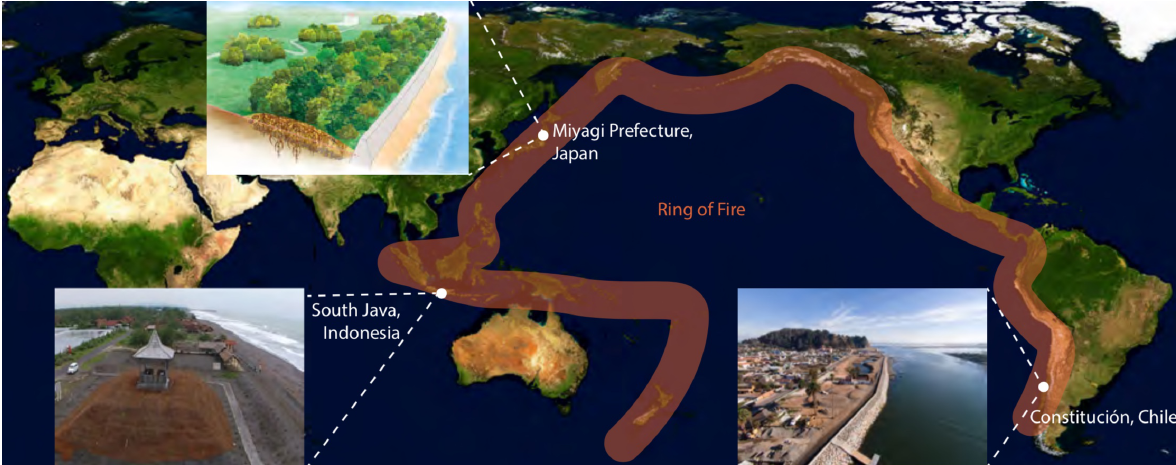
Figure 1. Pieces of the Tohoku multi-billion dollar tsunami protection wall after a level-2 tsunami his the coasts of Japan in 2011. While each individual concrete section of the wall did not suffer significant damage, the erosion at the foundations of the wall happened so quickly that the concrete barrier simply fell (Picture taken from in [13]).